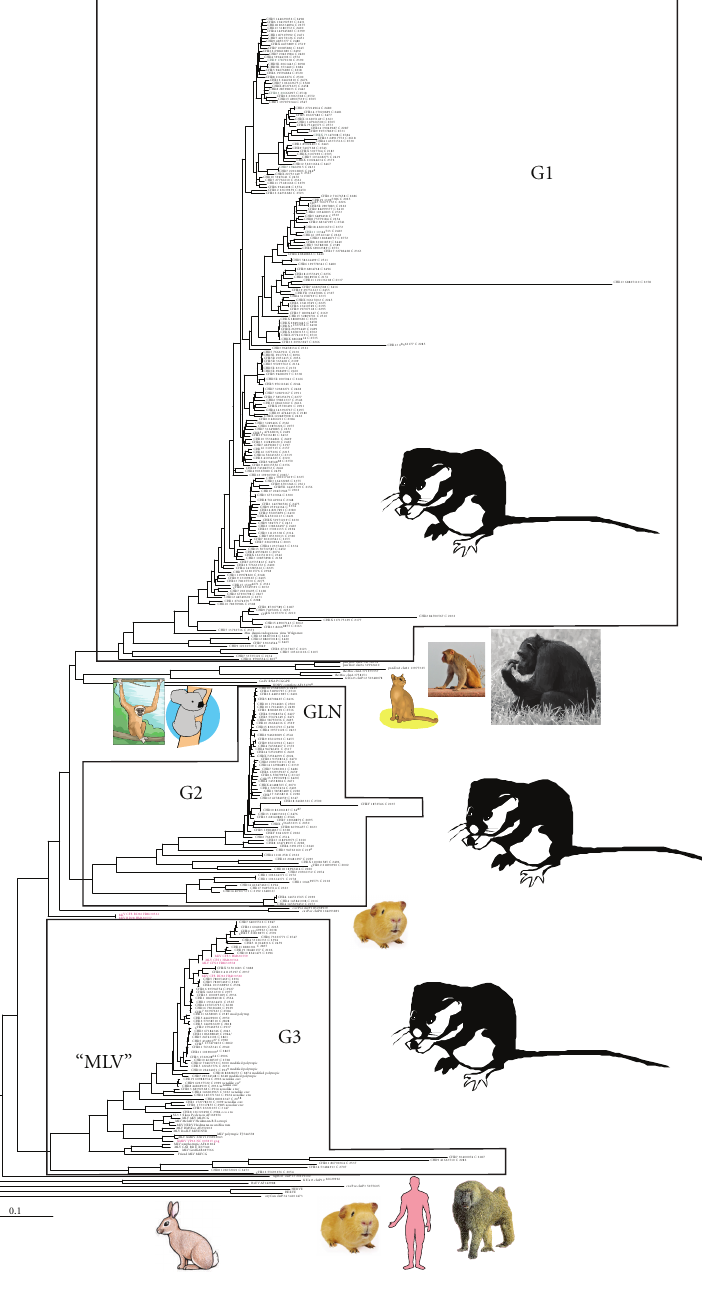
Figure 4: gag sequences of 300 high scoring mouse gammaretroviral sequences were aligned together with reference sequences. MLV sequences with ascribed tropism, from GenBank, were also added. The tree was rooted with a divergent rabbit gammaretrovirus-like sequence from sca ff old 34, position 34101473 (oryCun1 assembly). Sequences in red (“HMRV”) are from the paper of Lo et al. [56]. They were from ME/CFS patients (“CFS”) or blood donors (“BD”). Two blood donor sequences from the Lo et al. study came out at the base of group G2, in other trees (not shown) at the base of group G3. The other emerged in group G3. The branch labels are either ERV host genus, chromosomal position, provisional genus (“C”: gamma), and ReTe score, or a reference Pol name. Genomic ERV sequences taken from the prototype of RetroBank were named as oryCun: rabbit, cavPor: guinea pig, felCat: cat, panTro: chimpanzee, or rheMac: rhesus macaque. Mouse sequences are just shown with their chromosomal